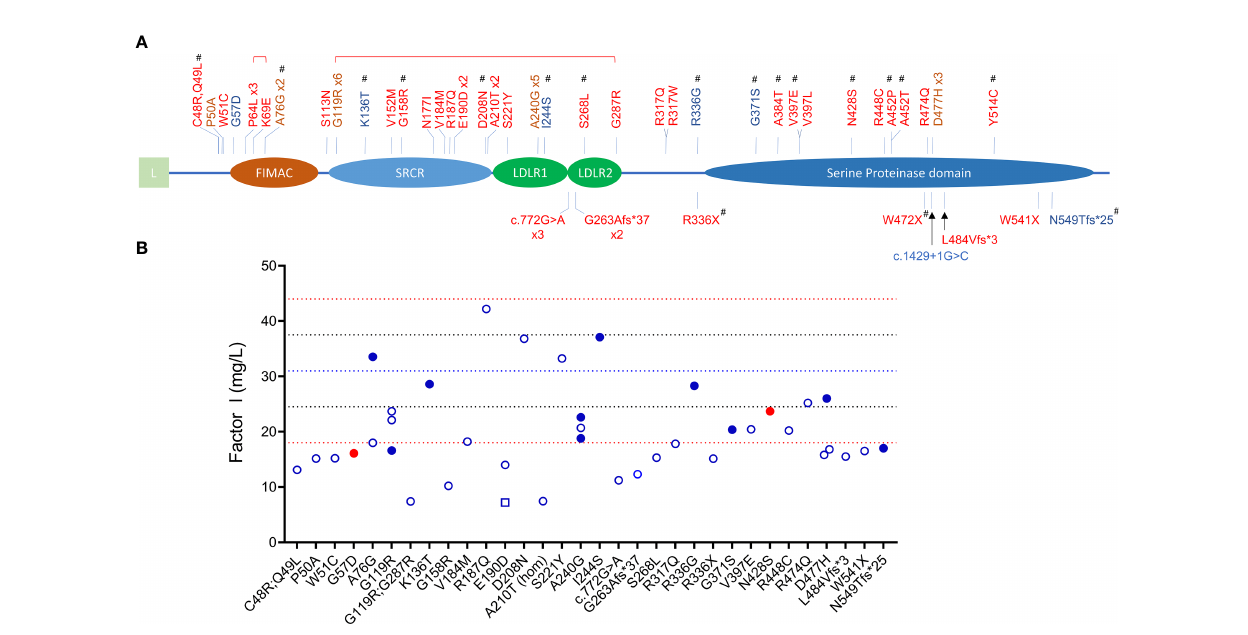
FIGURE 1 | CFI variants identi fi ed in patients with C3G and aHUS. (A) Schematic view of factor I and the 45 rare variants (MAF < 0.1%) identi fi ed in 65 patients (red, aHUS; blue, C3G; brown, both C3G and aHUS). All variants were identi fi ed in heterozygosis except one homozygote (p.Ala210Thr) and two compound heterozygotes (brackets above variants indicate compound heterozygosity). Novel variants are marker with #. (L, leading sequence; FIMAC, Factor I Membrane Attack Complex; SRCR, Scavenger Receptor Cysteine-Rich; LDLR, Low-Density Lipoprotein Receptor). (B) FI levels in 40 patients (open circles, aHUS; fi lled blue circles, C3GN; fi lled red circles, DDD; open square, C3G/aHUS; dashed lines, reference values: red, upper and lower limits of normal; blue, percentile